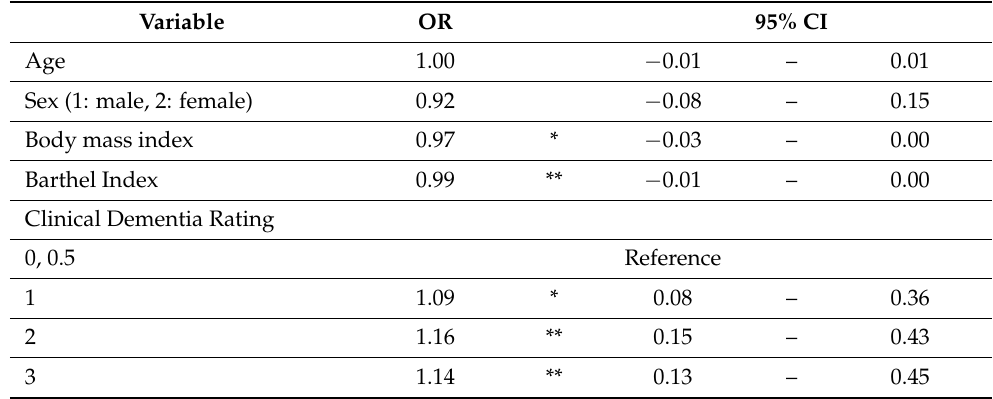
Table 4. Adjustment